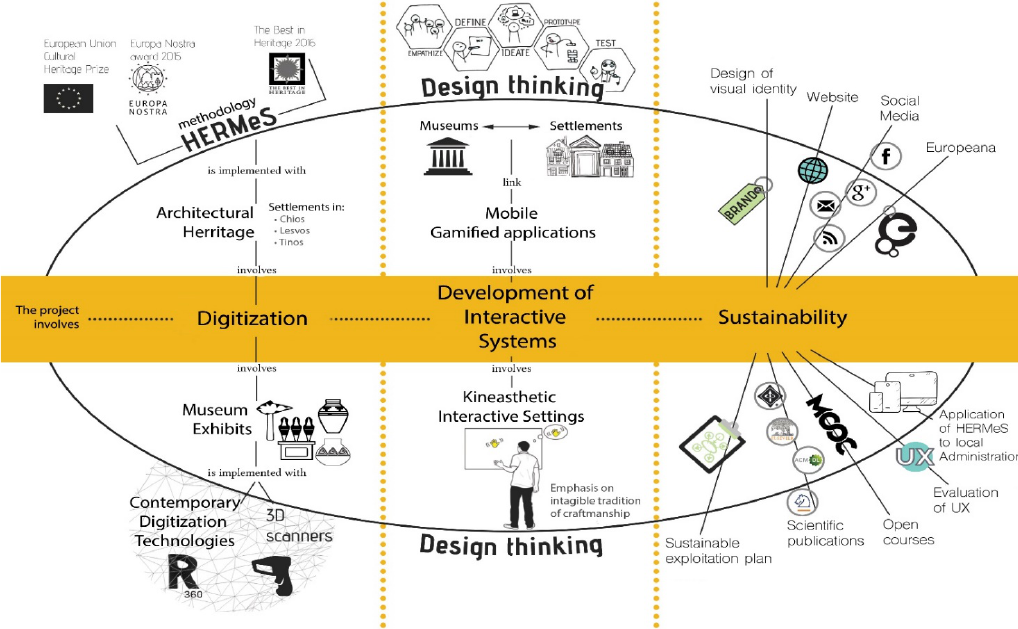
Figure 1. Concept model of the Mouseion Topos project.